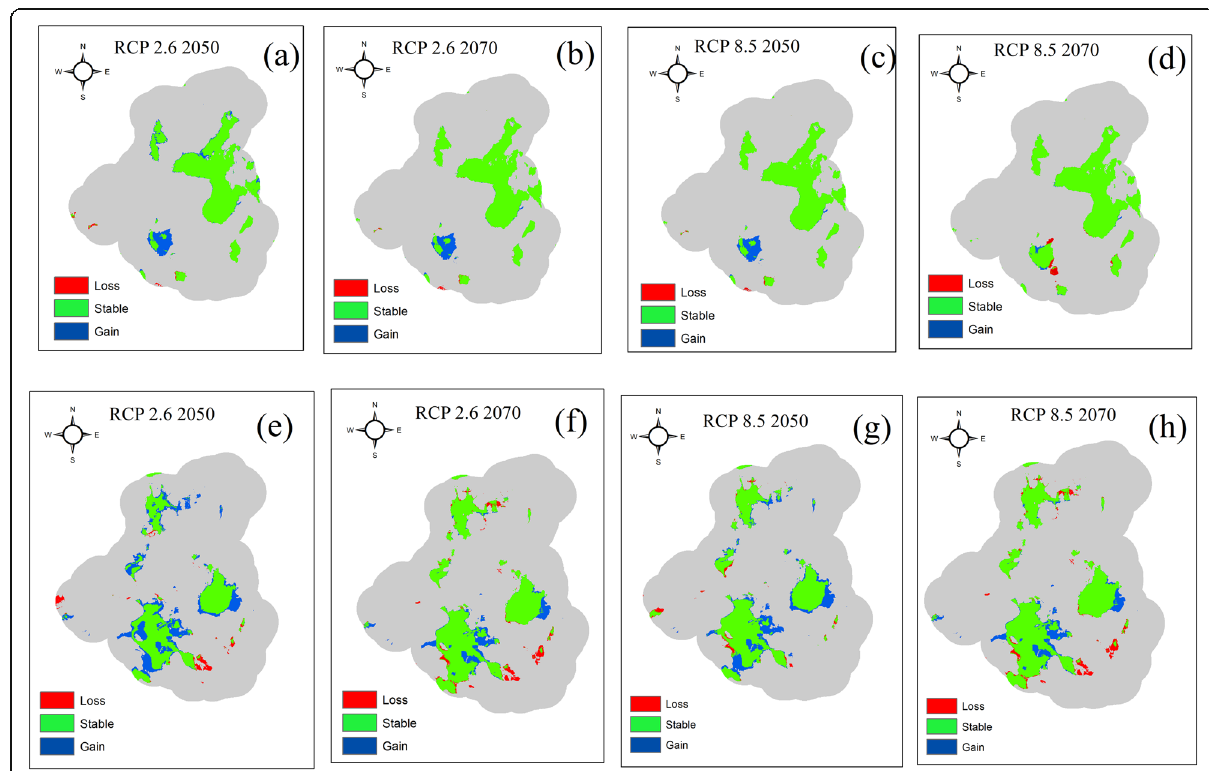
Fig. 6 Predicted change in the distribution of Indian fox and golden jackal under RCP 2.6 and RCP 8.5 scenarios: portions a – d represent the predicted gain and loss for Indian fox, and portions e – h represent the gain and loss in the distribution of golden jackal for the timelines (the 2050s and